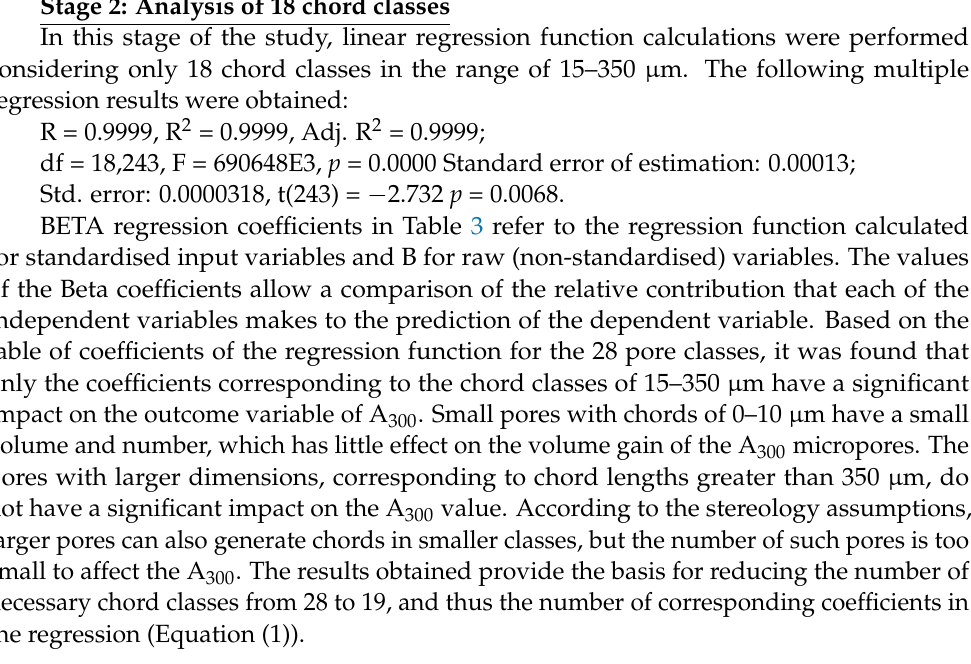
Table 3. Coefficients of the regression function with the assessment of their significance considering 18 chord